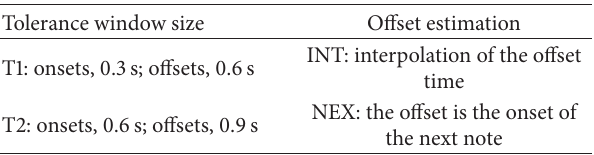
Table 3: Score information used for the initialization of score- informed source